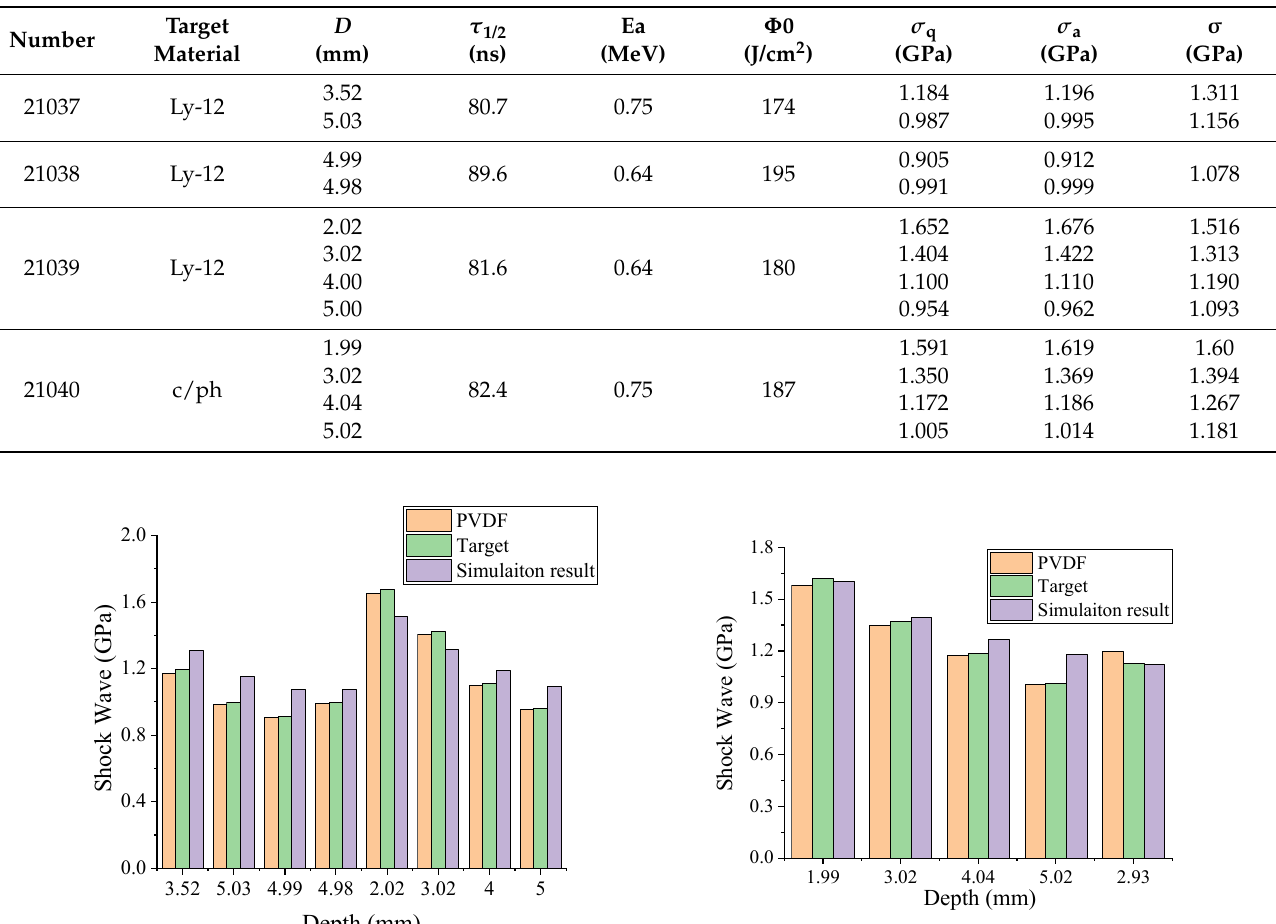
Table 4. Measured and calculated data of thermal shock waves.